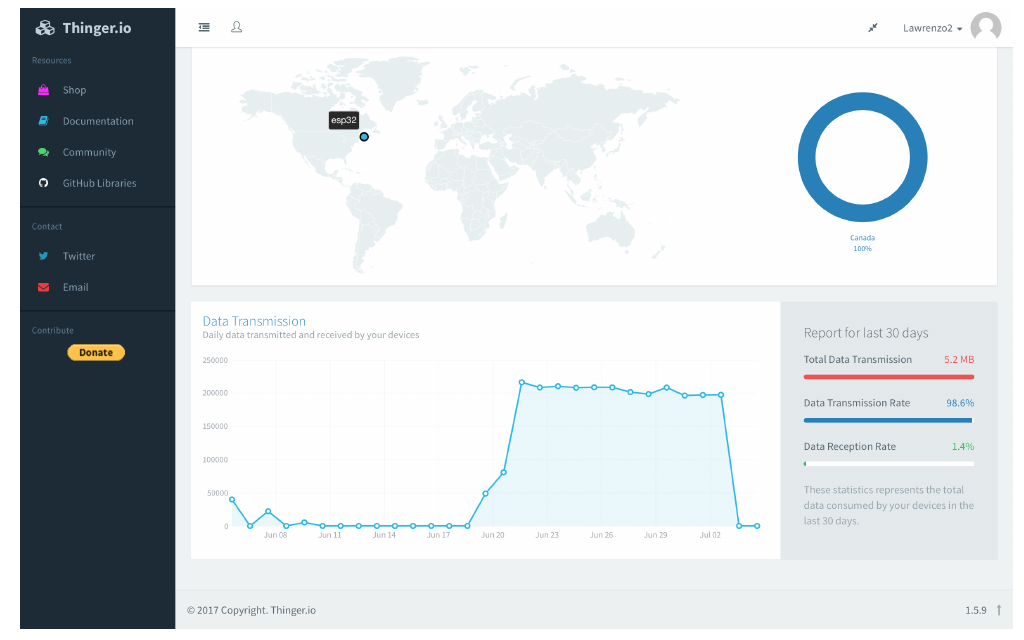
Figure 12. Logged data history on Thinger.IO